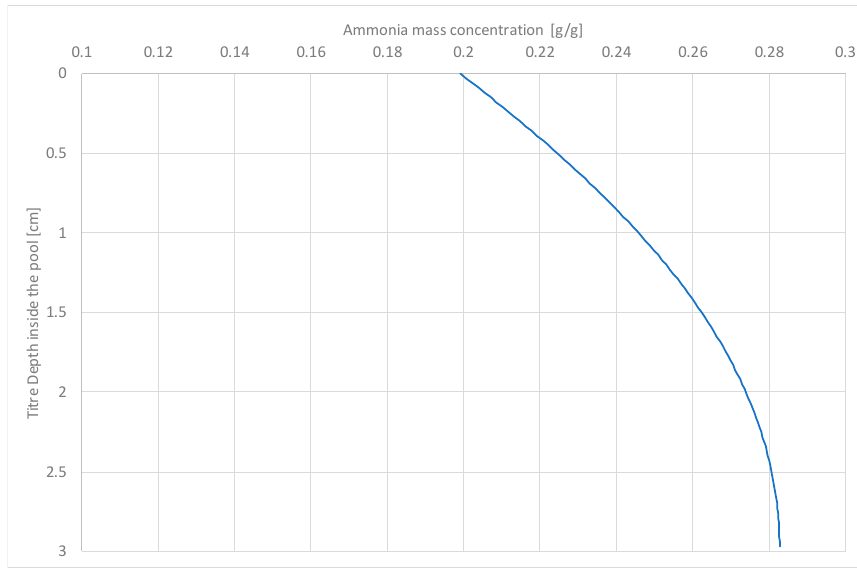
Figure 16. Ammonia concentration along the pool depth; 0 is the pool surface.